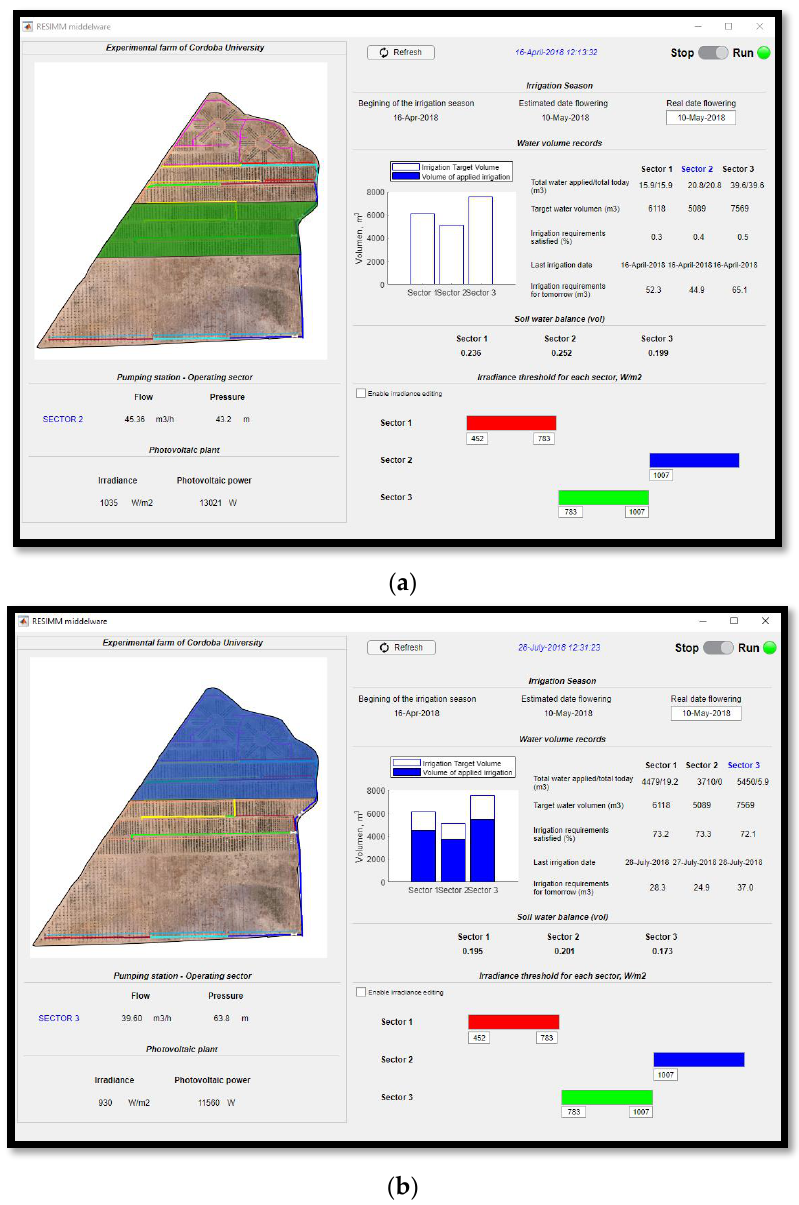
Figure 8. Screenshots of the RESSIM model on the Julian day of the year 106 ( a ) and 209 ( b ).